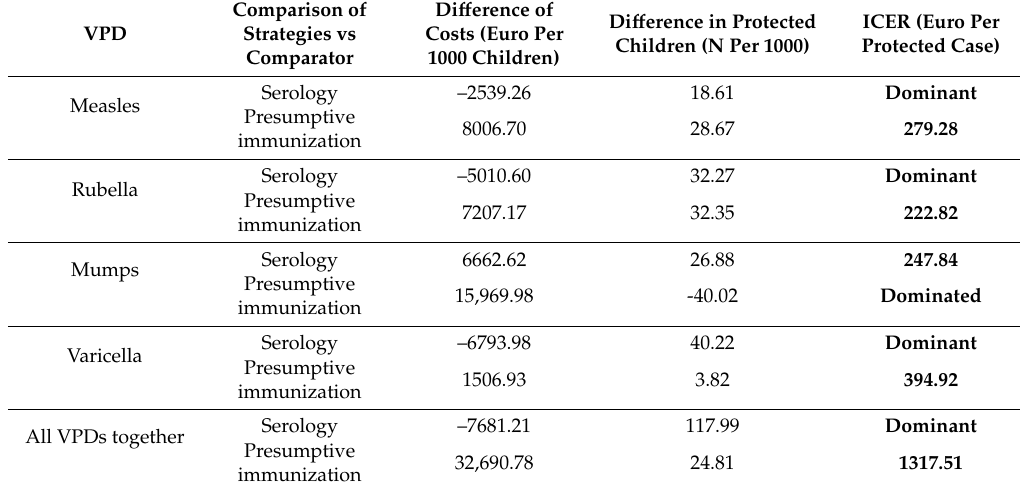
Table A2. Comparison of strategies according to di ff erent VPDs (CLIA